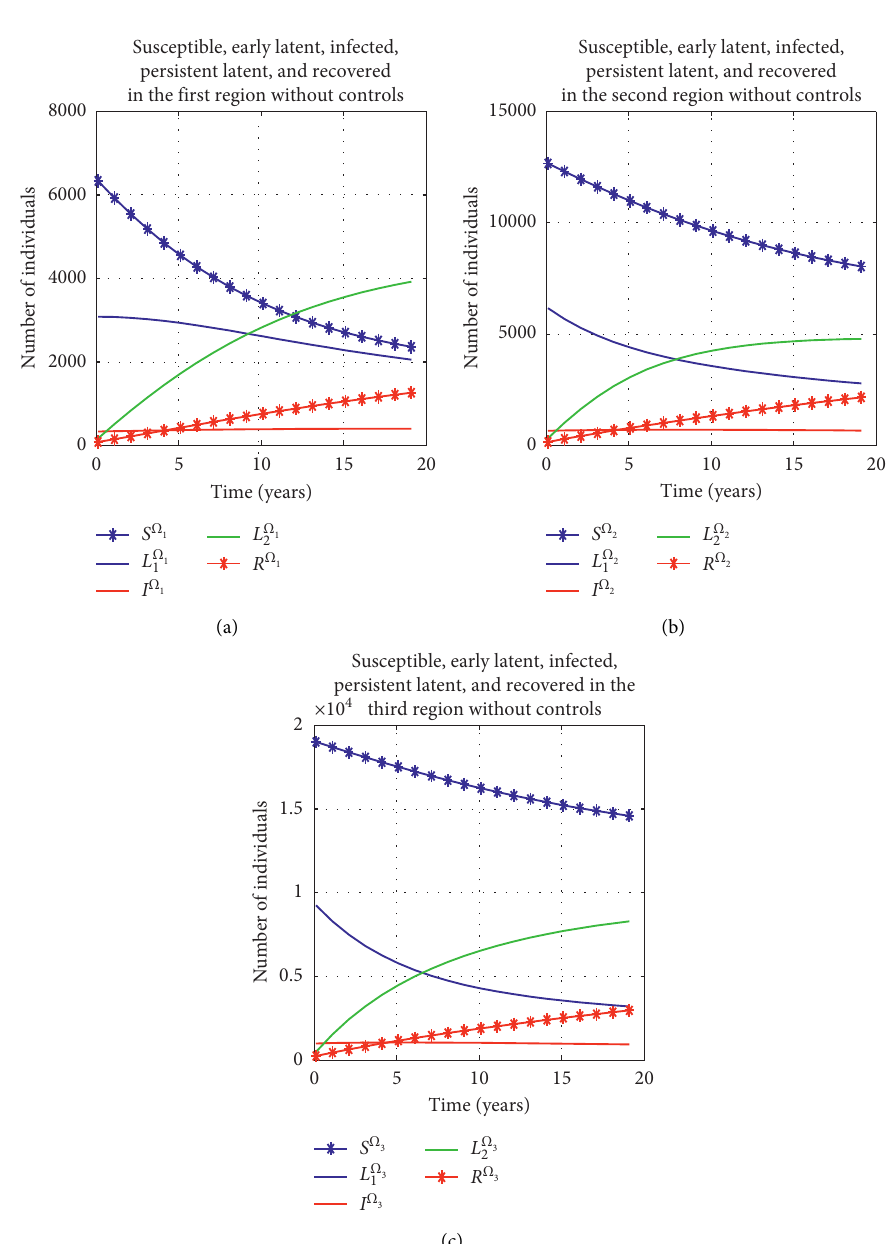
Figure 2: The state variables in three regions without